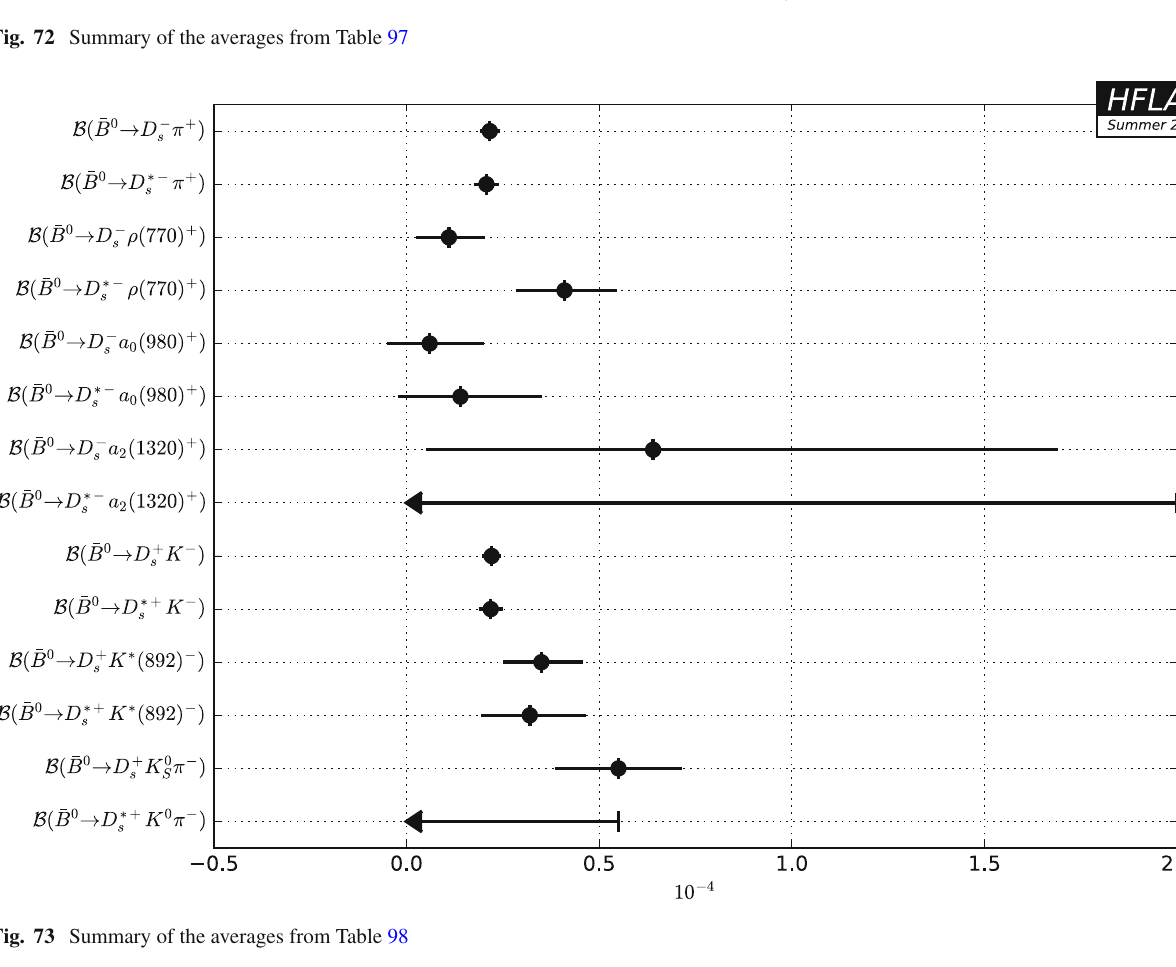
Fig. 73 Summary of the averages from Table